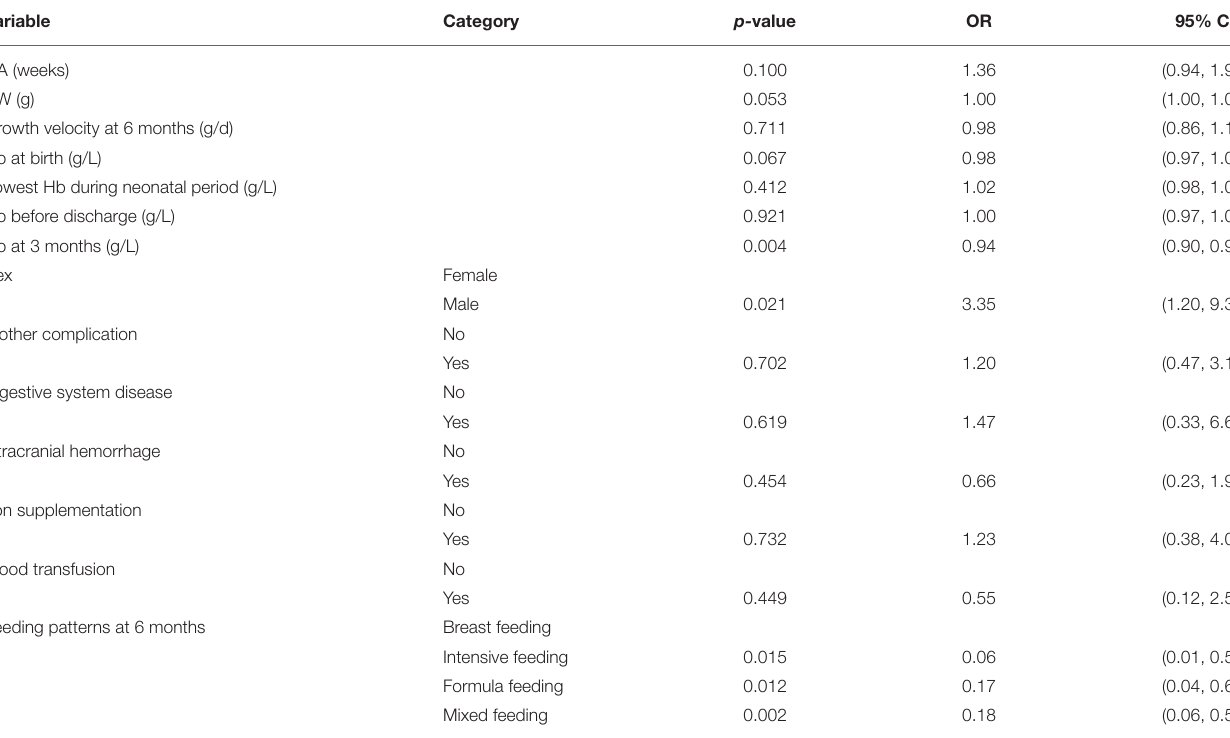
TABLE 5 | Factors associate with ID/IDA at 6